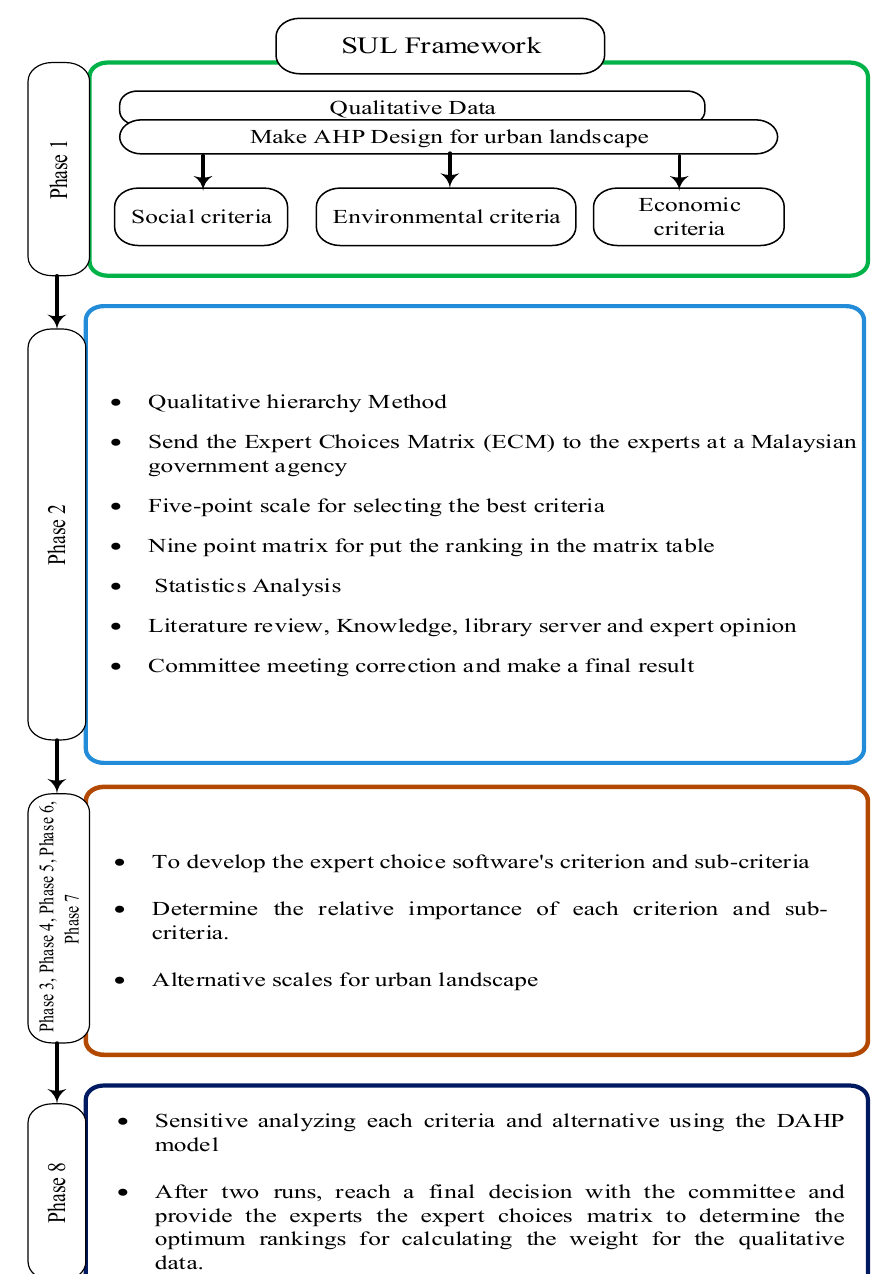
Figure 2. DAHP model framework, showing the eight computational phases.